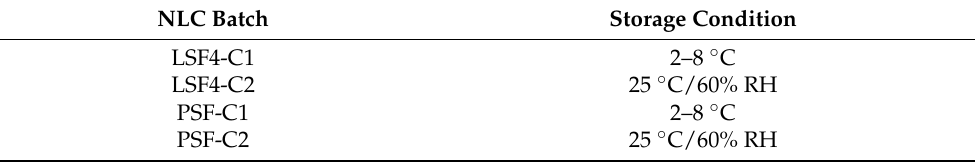
Table 1. Storage and sample details for 6-month stability study at a certified storage